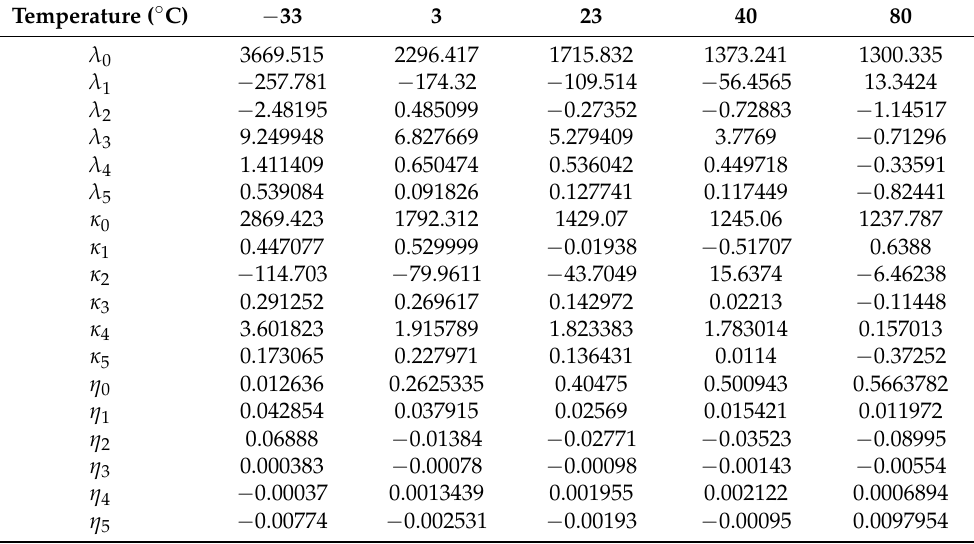
Table 1. Parameters of the simulation environment.